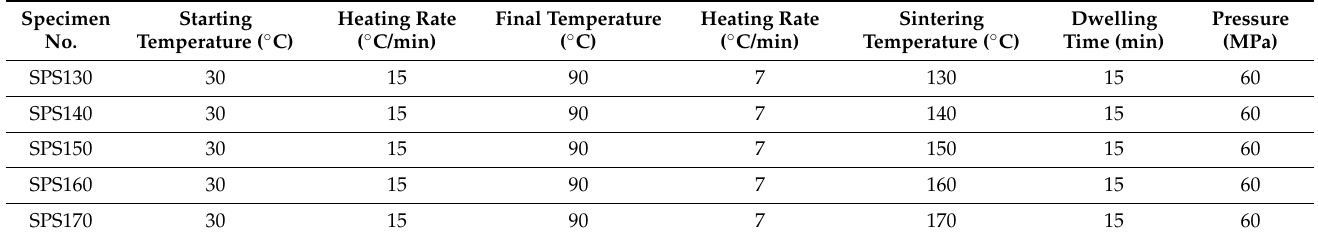
Table 2. Detailed experimental procedure used in spark plasma